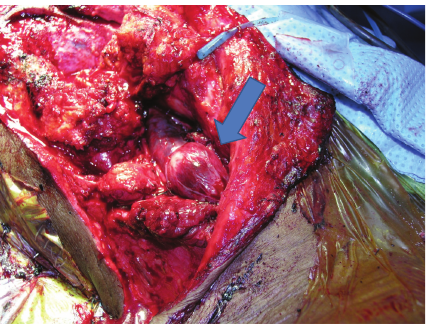
Figure 4: Intraoperative photo demonstrating extension of menin- gioma within the internal jugular vein to the midneck (arrow).